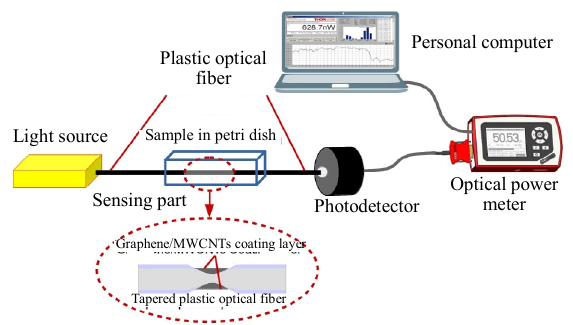
Fig. 3 Experimental setup for performance evaluation of the proposed fiber sensor.